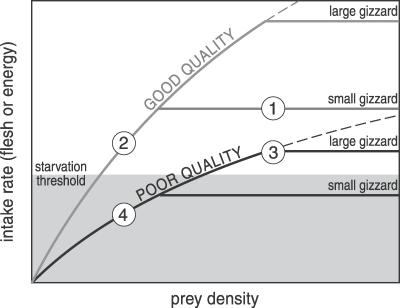
Conceptualization of Why a Simultaneous Reduction in Density and Quality of the Prey is DetrimentalHolling's Type II functional response describes intake rate (be it flesh or energy) as a function of the density of either poor-quality (black lines) or good-quality (gray lines) prey. Digestive constraint limits shell-mass processing rate and is given for two gizzard sizes for each prey quality (horizontal cut-offs in functional response; digestively unconstrained intake rates continue as dashed lines). By knowing the threshold intake rate needed to avoid starvation (border between gray and white background), one can predict a bird's starvation chances on the basis of gizzard size and prey quality and density. (1) A small gizzard is sufficient to stay alive when prey is of good quality and occurs in high densities. Going from (1) to (2), prey density is reduced, which does not affect survival as intake rate remains above the critical threshold. Going from (1) to (3), prey quality (flesh-to-shell ratio) is reduced. To maintain a sufficient intake rate, the knot needs to increase its shell-mass processing rate, which requires a gizzard enlargement. Going from (1) to (4), the combined reduction in density and quality makes a gizzard enlargement no longer sufficient (as intake rate is now constrained by prey density), and the bird is bound to starve.